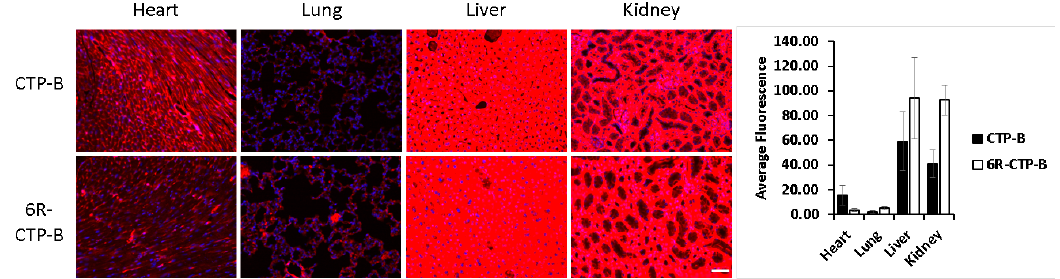
Figure 1. Fluorescent micrographs of heart, lung, liver and kidneys from mice euthanized 15 min after an intravenous injection with fluorescently labeled CTP-B or 6-Arginines-CTP-B. N = 3 for each peptide. Scale bar represents 50 μ m.